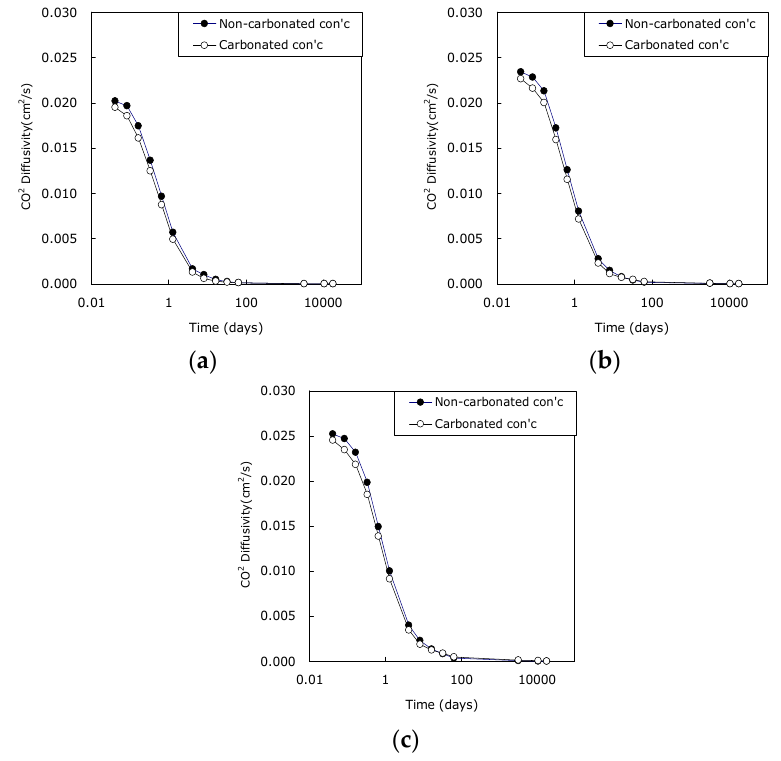
ff ective di ff usivity. ( a ) w / c 0.45; ( b ) w / c 0.50; ( c ) w / c 0.55. 2 e